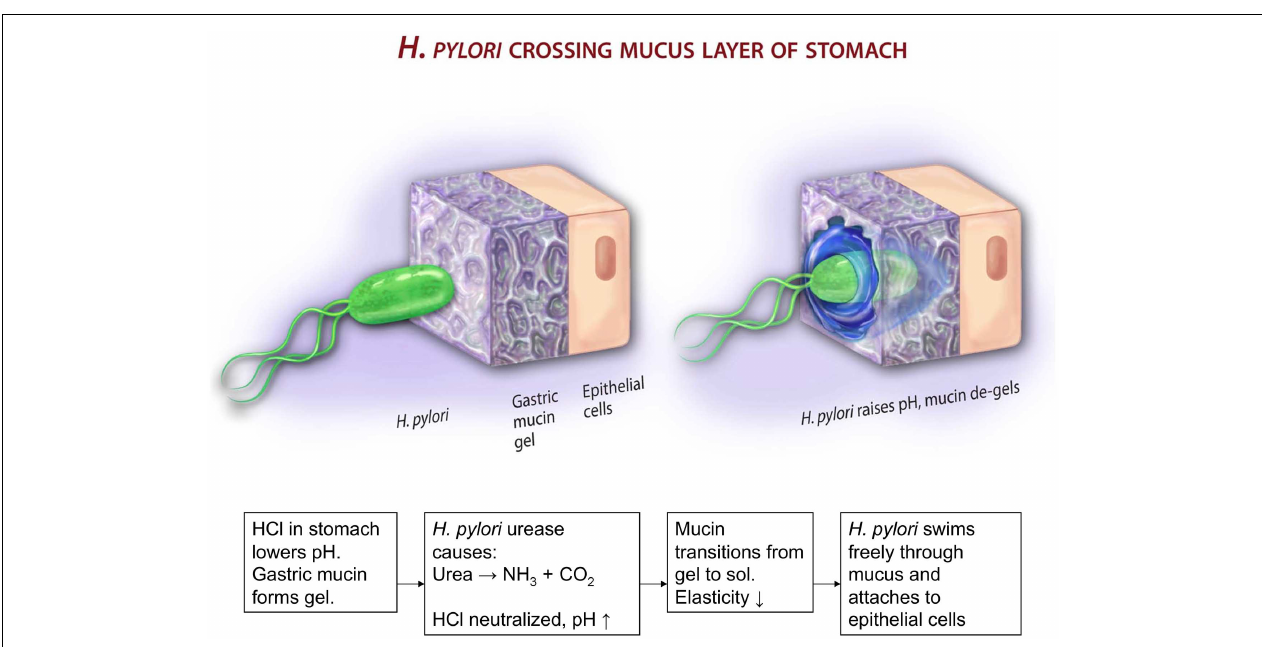
pH.This de-gels the mucin, and enables the bacterium to swim in the resulting polymer solution.The picture, not copyrighted, is reproduced from an NSF press release 09-149. http://www.nsf.gov/news/news_summ.jsp? cntn_id=115409&org=NSF&from=news